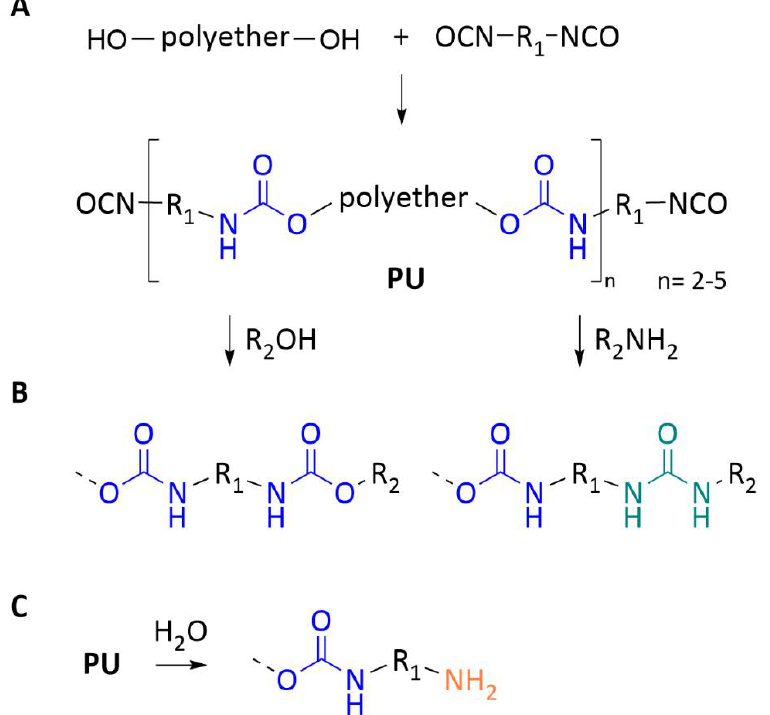
Figure 1. General scheme for the preparation of a PU prepolymer from macrodiol and diisocynate reagents ( A ) and the corresponding products from the reaction with alcohols and amines ( B ) and hydrolysis in the presence of water ( C ).